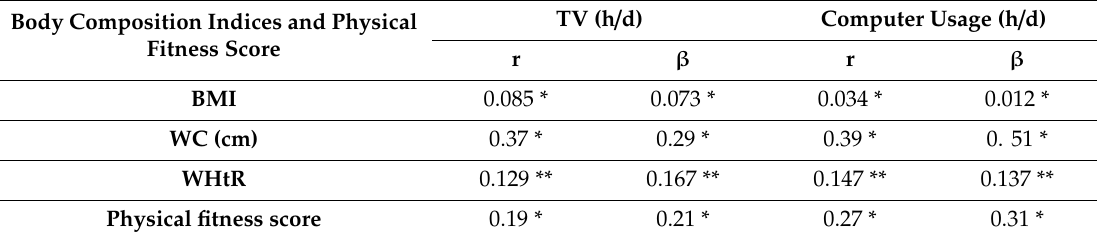
Table 6. Correlation between body composition indices, physical fitness score and media usage among participants using partial correlation and multiple regression